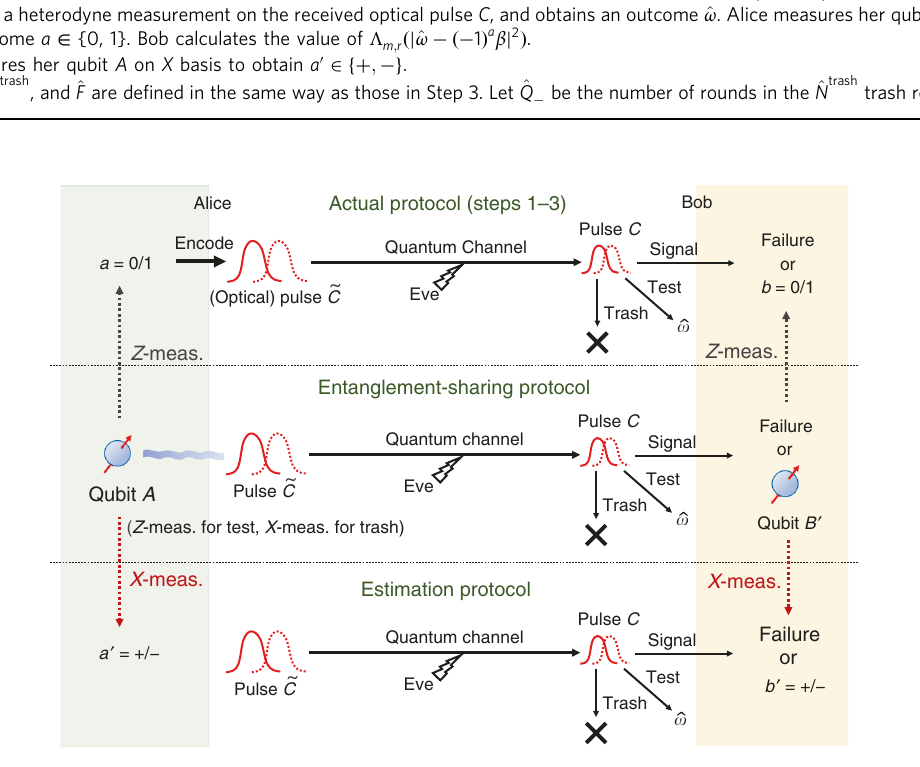
Fig. 4 Relation between three protocols. The actual protocol and the estimation protocol are related through the entanglement-sharing protocol. After the entanglement-sharing protocol, Alice and Bob are left with the observed data ð ^ N suc ; ^ N fail ; ^ N test ; ^ N trash ; ^ F ; ^ Q (cid:2) Þ and ^ N suc pairs of qubits. If Alice and Bob ignore